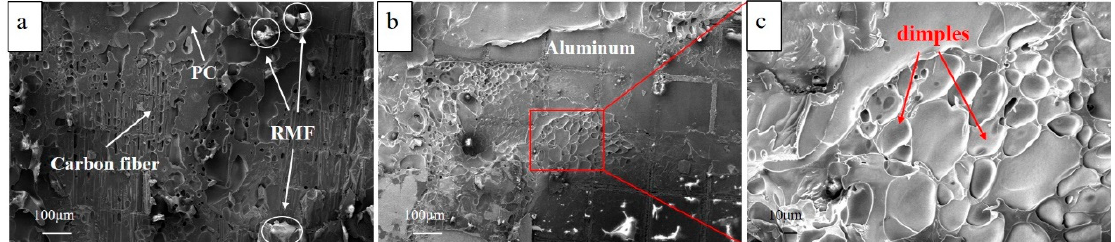
Figure 8. SEM image of fracture surface ( a ) CFRP side; ( b ) aluminum side; ( c ) magnified red area in (b).